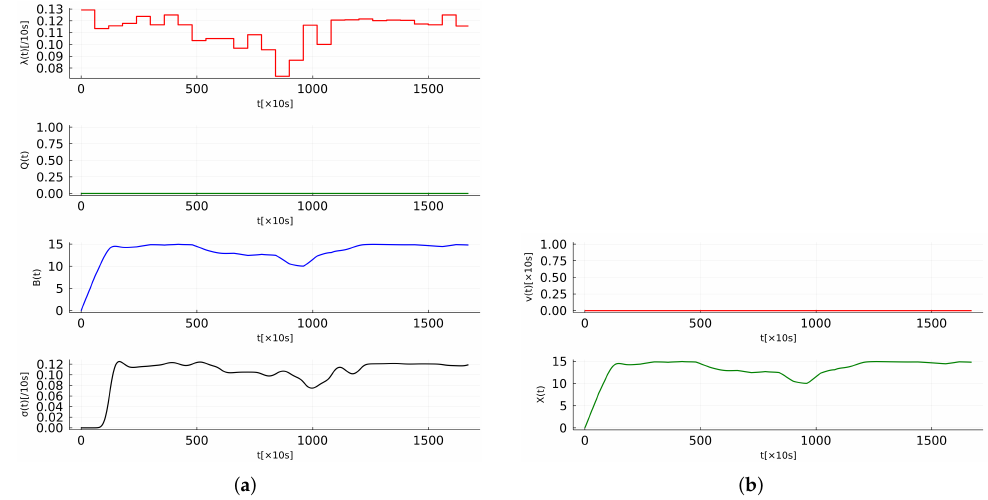
Figure 11. Calculation results of Scenario 1 with s av ( t ) = 15.0, g av ( x ) , and f av ( x ) . ( a ) λ av , n = 10 ( t )